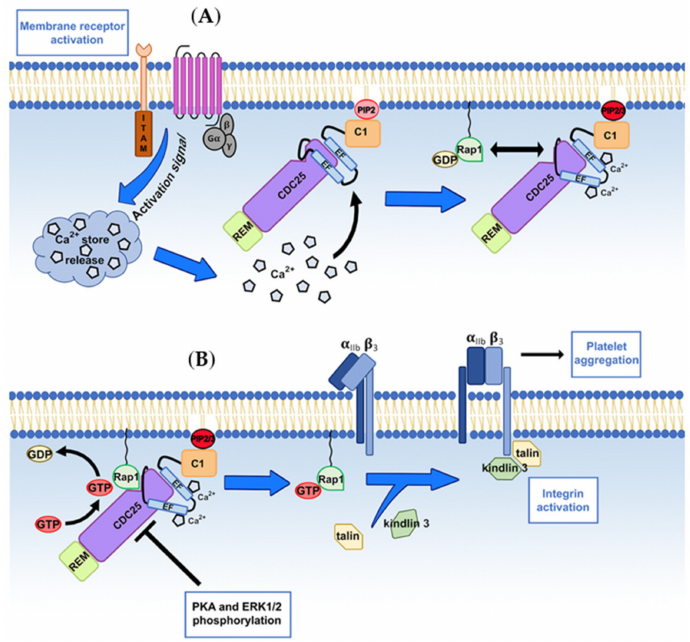
Figure 2. RasGRP2 activation mechanism and activity regulation during α IIb β 3-integrin “inside-out” signaling in platelets. ( A ) Platelet surface receptor activation by vascular adhesive proteins and / or soluble agonists initiates an intracellular activation signal that induces the release of Ca2 + from intracellular stores into the platelet cytoplasm. Ca2 + binding to the EF hands induces